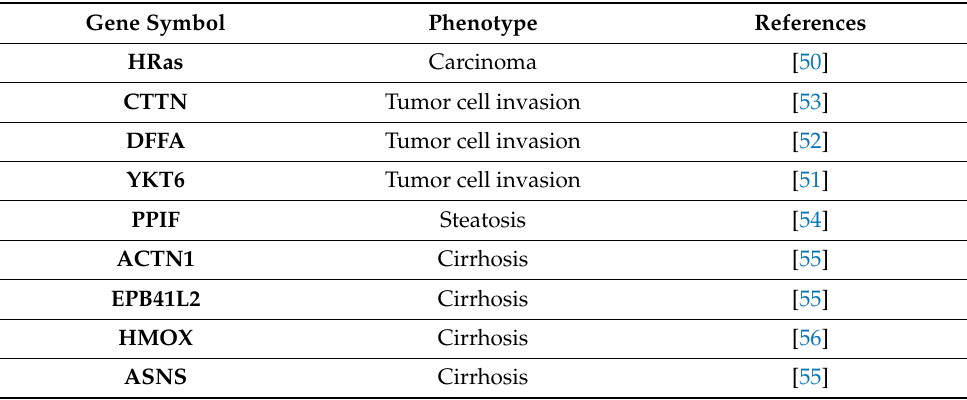
Table 3. Genes associated with liver pathology according to the DisGeNET database